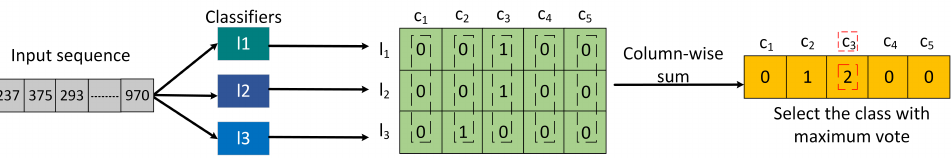
Figure 5. Example of hard-level voting.